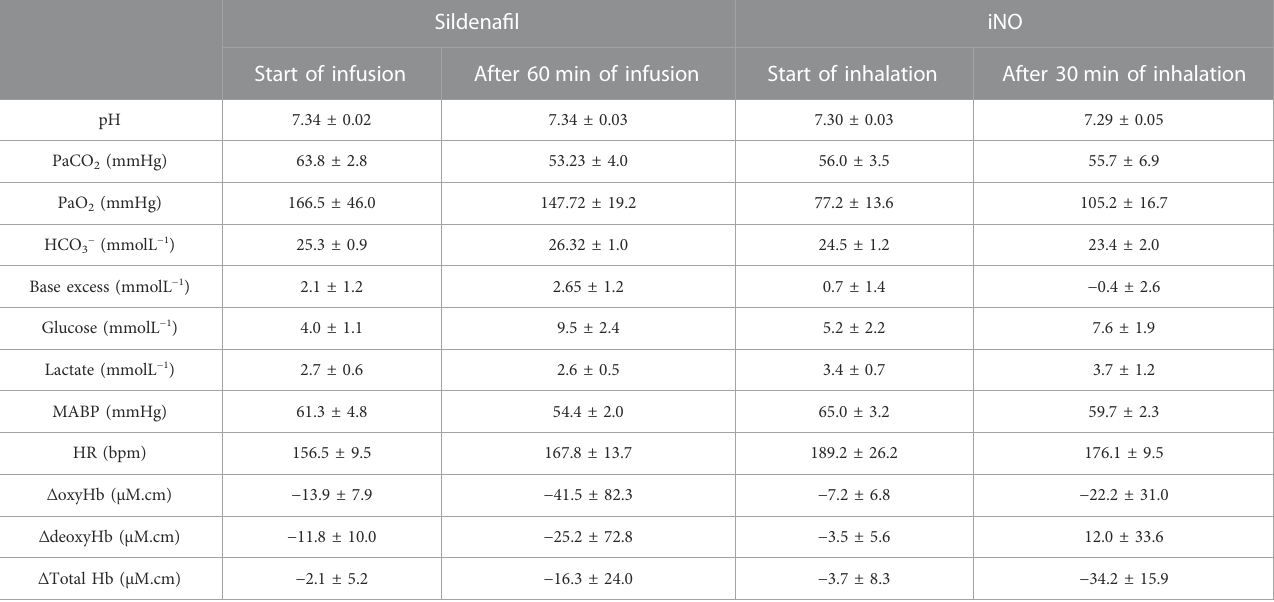
TABLE 4 Arterial blood gases, mean arterial blood pressure (MABP), heart rate (HR) together with EEG and NIRS data of preterm lambs at the start and after 60 min of sildena fi l infusion ( n = 6) or 30 min of iNO inhalation ( n = 8) (values are mean ±